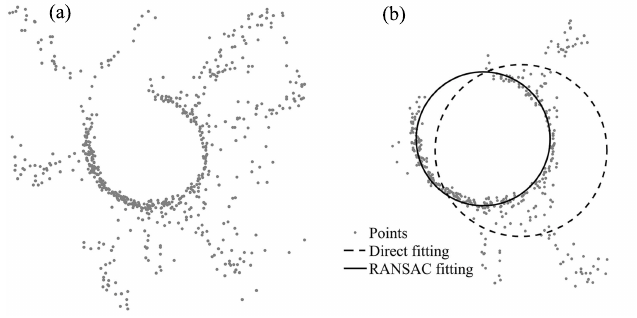
Figure 16. An example of the effectiveness of RASANC algorithm in circle fitting. The outliers in original points ( a ) are first filtered by the region growing method ( b